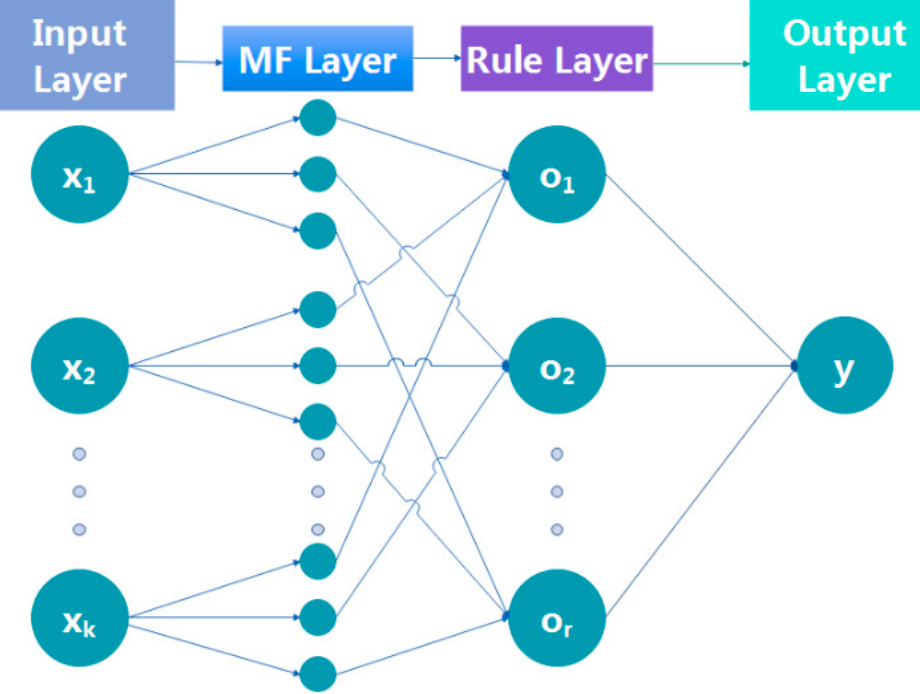
Figure 1. Fuzzy neural network structure diagram.